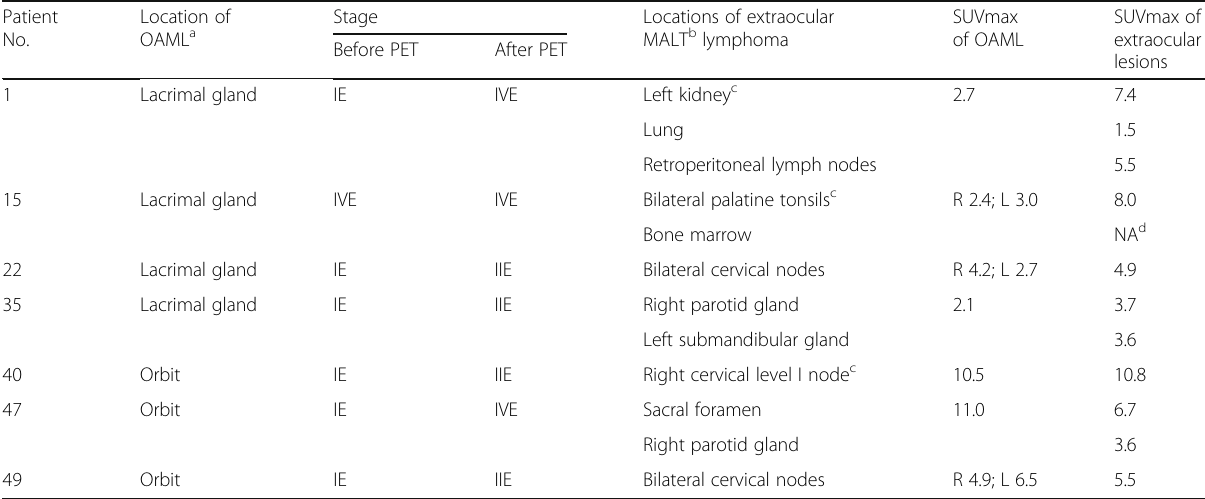
Table 3 Characteristics of extraocular lesions detected in seven patients Patient